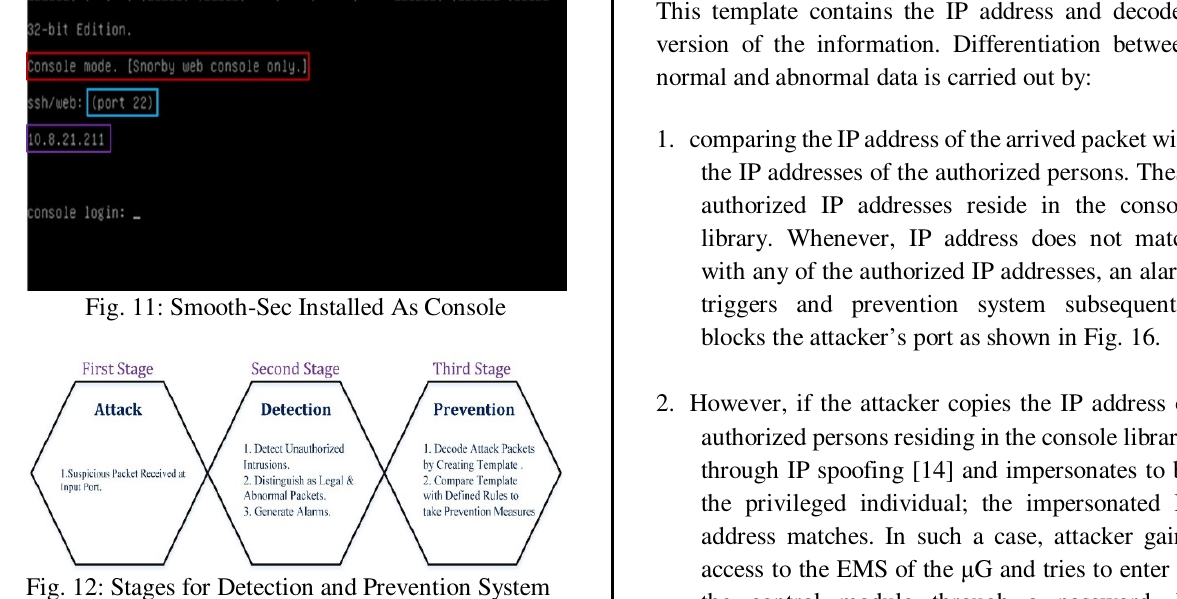
Fig. 12: Stages for Detection and Prevention System